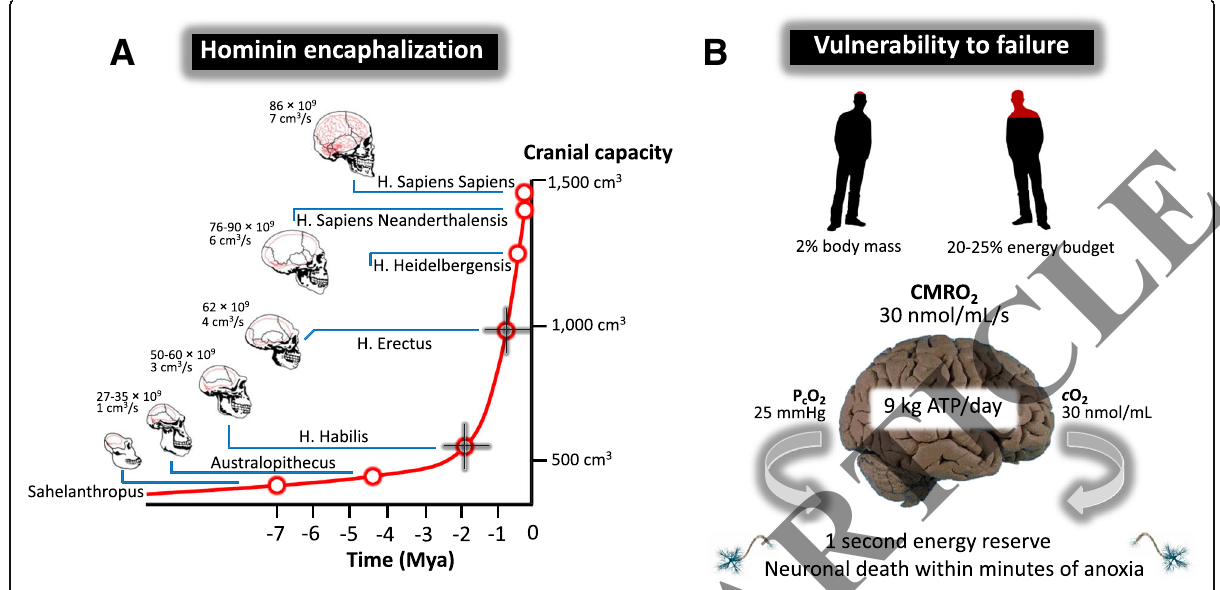
Fig. 2 Evolution of the hominin brain and vulnerability to failure. a Exponential increase in cranial capacity observed in fossil hominids over time beginning with Homo Habilis and marked encaphalization linked to the physically active “ Hunter Gatherer ” , Homo Erectus (annotated). Data based on the (calculated) mean of published individual data points (Schoenemann 2006). Note also the increase in total number of neurones estimated from separate derivations of cranial capacity and corresponding increases in cerebral blood flow calculated from the size of the internal carotid foramina, in relation to endocranial volume (Seymour et al. 2016). b The human brain ’ s oxygen (O 2 ) dependence comes at a cost with a corresponding high vulnerability to failure given that it is an entirely aerobic organ characterized by limited energy reserves that becomes evident when confronted by complete oxygen lack (anoxia). CMRO 2 , cerebral metabolic rate of oxygen; PcO 2 (average) cerebral tissue partial pressure of O 2 ; c O 2 , cerebral oxygen